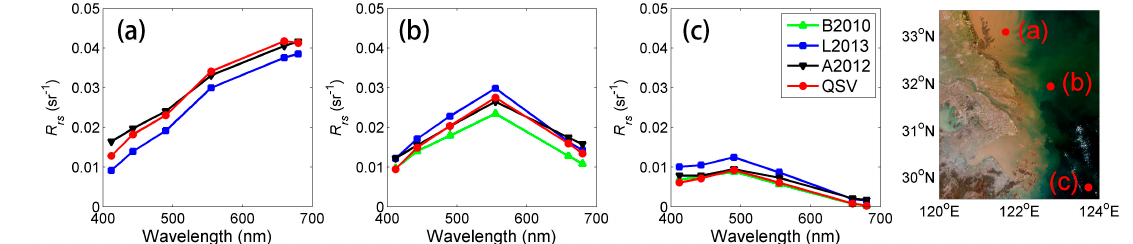
Figure 6. Comparisons of the R rs spectra derived from four different algorithms in highly turbid waters at station ( a ), moderately turbid waters at station ( b ), and clear waters at station ( c ). The RGB image shows the locations of the three stations.